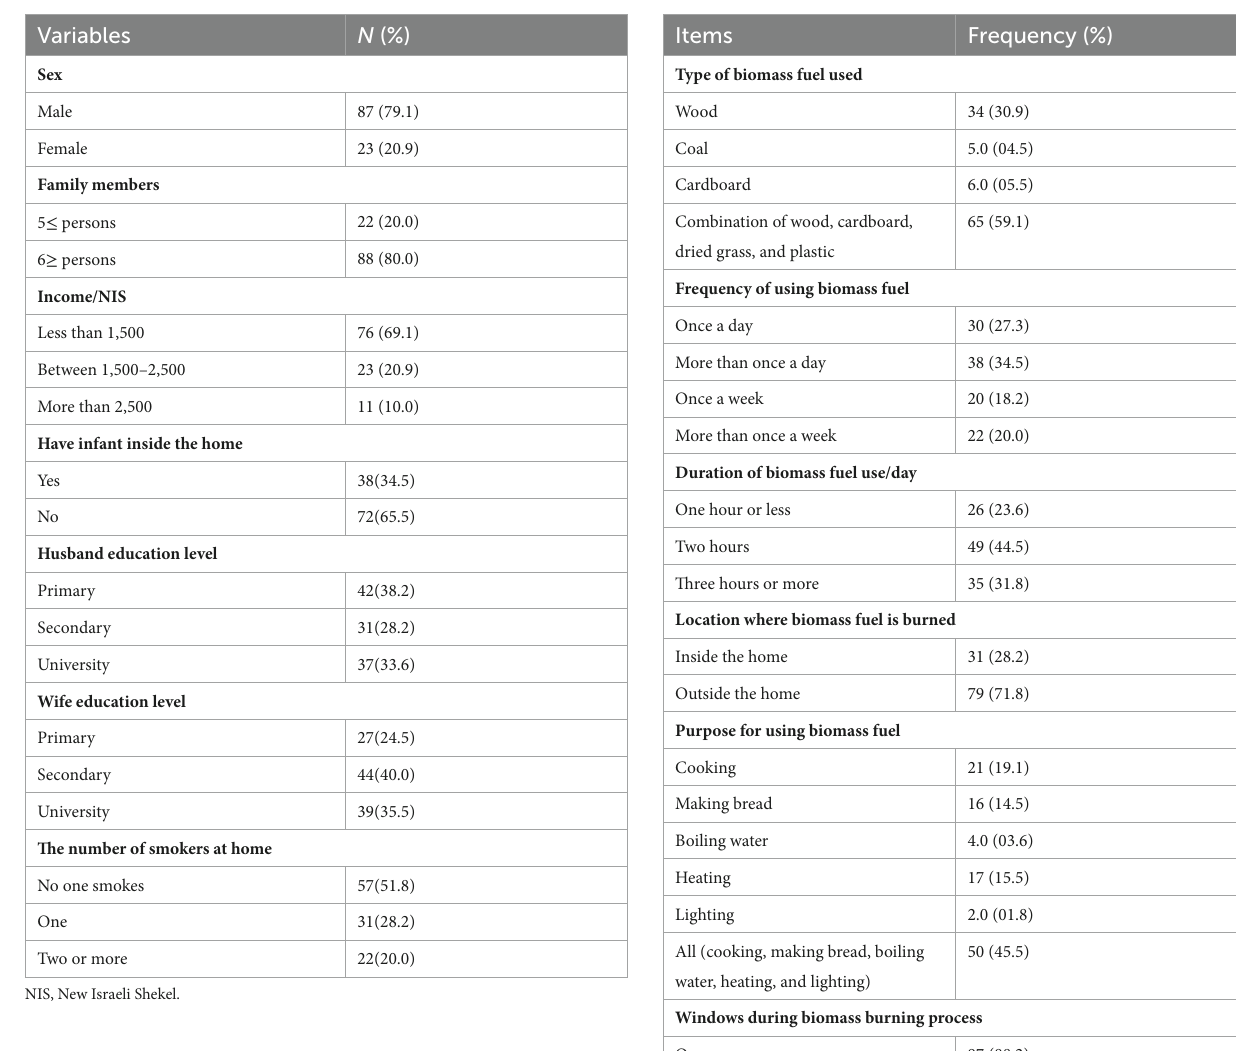
TABLE 1 Characteristics of the study participants. TABLE 2 The use of biomass